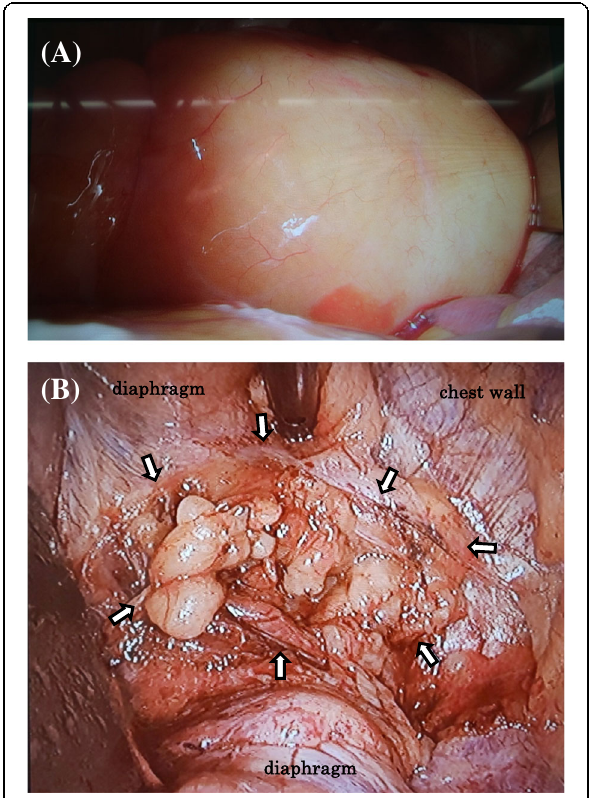
Fig. 3 a A fatty mass of 28 cm in size, which seems to be retroperitoneal fat, slid into the thoracic cavity. b The hernia orifice (surrounded by white arrows) is composed of the right lumbocostal